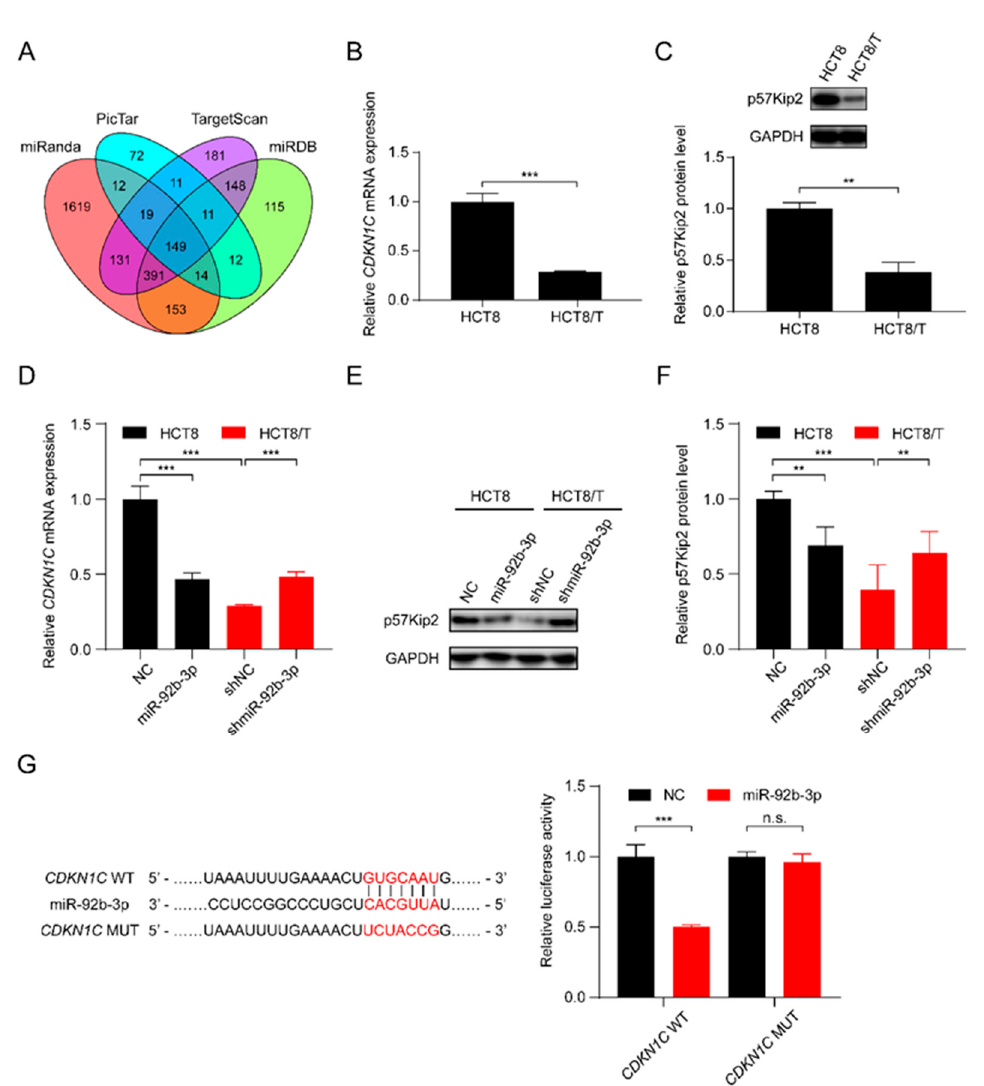
Figure 3. miR-92b-3p directly targets CDKN1C and suppresses its expression. ( A ) The potential target of miR-92b-3p by bioinformatics analysis ( B , C ) The p57Kip2 expression levels in HCT8 and HCT8/T cells by qRT-PCR and western blotting analysis. Detailed information about Western Blot can be found at supplementary materials. ( D – F ) The p57Kip2 expression levels in miR-92b-3p overexpressing HCT8 cells and miR-92b-3p knockdown HCT8/T cells by qRT-PCR and western blotting analysis. Detailed information about Western Blot can be found at supplementary materials. ( G ) Validation of the direct target of miR-92b-3p by dual luciferase reporter assay. Firefly luciferase and Renilla luciferase activities in 293/T cells after co-transfection with NC or miR-92b-3p and wild-type or mutant 3 ′ UTR of CDKN1C by dual luciferase reporter assay. All experiments above were repeated three or more times independently and values are shown as mean ± SD. n.s. p > 0.05; ** p < 0.01; *** p < 0.001.